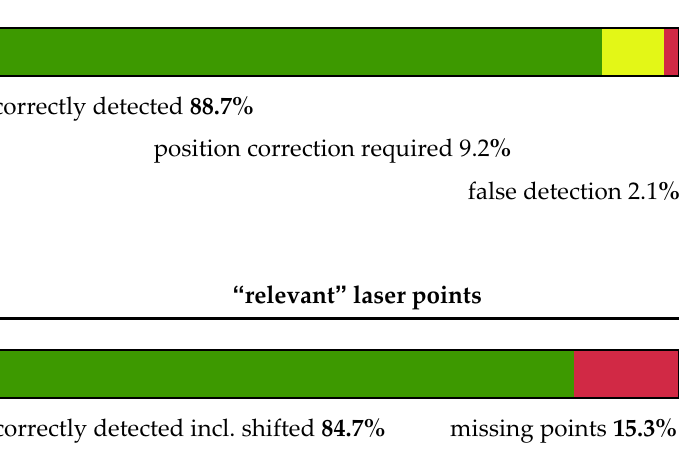
Figure 14. Evaluation of the automated initial grid detection algorithm including an analysis of the initially suggested laser grid ( top ) and the success with respect to the desired, objective grid ( bottom ).